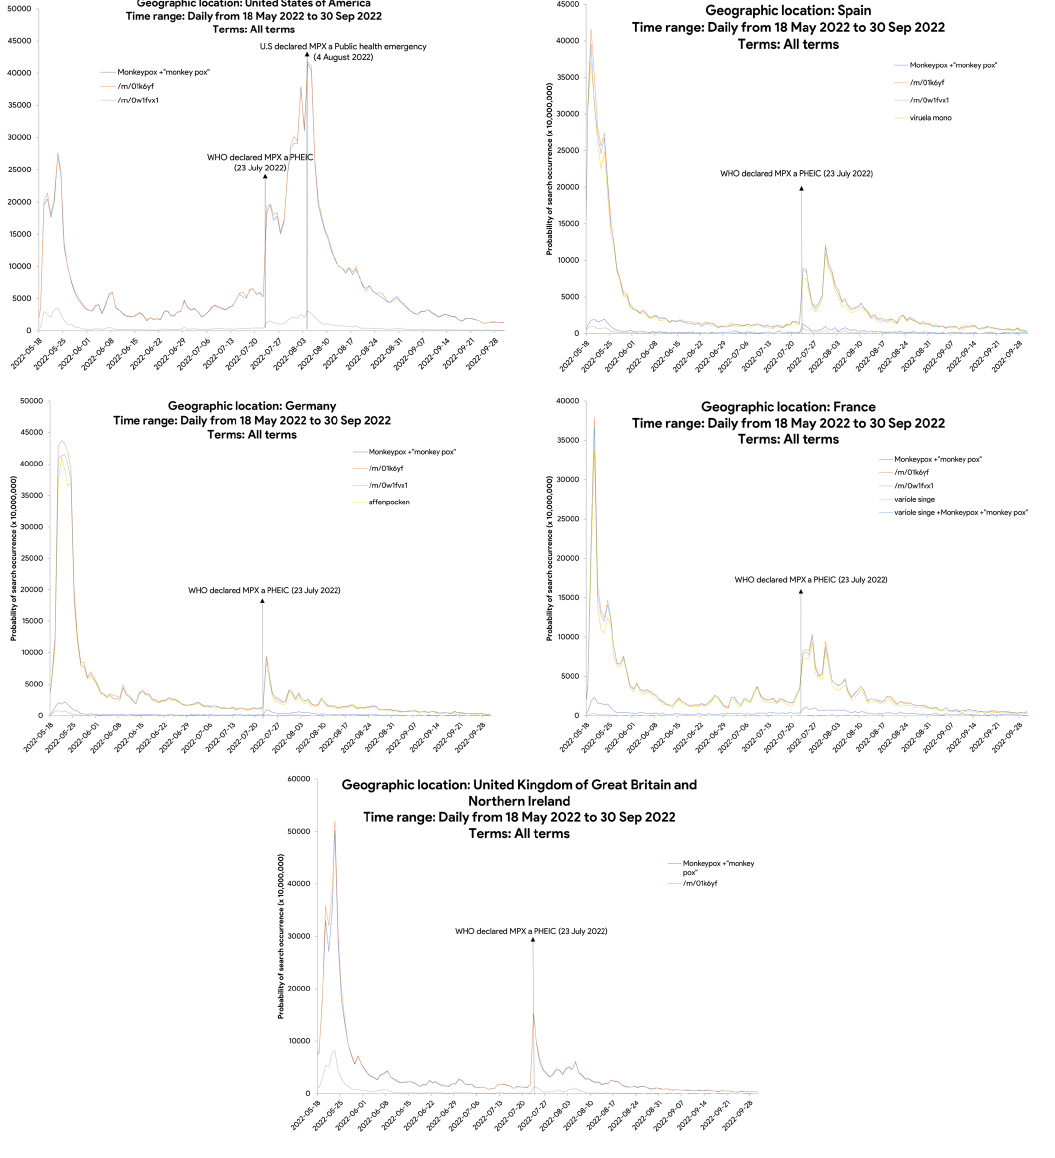
Figure 2. Google search probability before and after WHO declaration of Monkeypox outbreak as a Public Health Emergency of International Concern